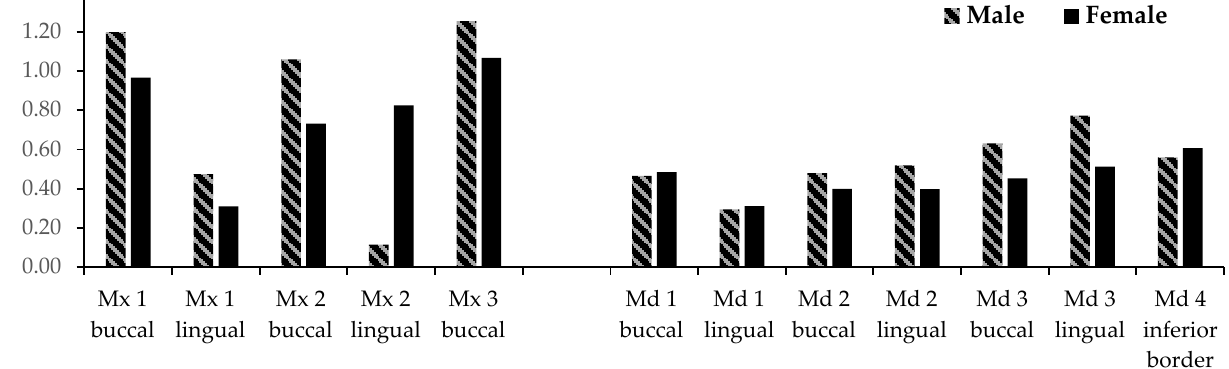
Figure 6. Dentoalveolar transverse changes per year at the first molar level of the maxilla and mandible for Males (stripes) and females (solid). Three coronal levels apical to the CEJ were examined. Mx/Md 1 is the most coronal level and Mx/Md 3 is the most apical level.